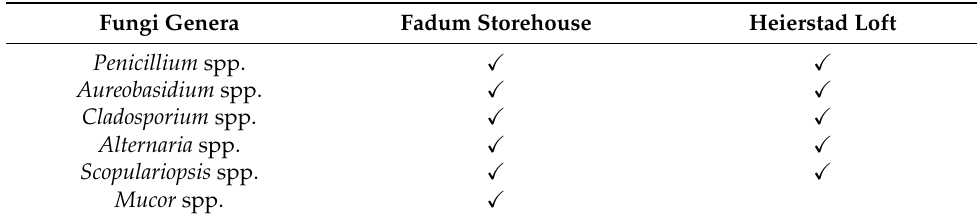
Figure 10. Fungal structures of ( a ) Penicillium spp. , ( b ) Aureobasidium spp. , ( c ) Cladosporium spp. , ( d ) Alternaria spp. , ( e ) Mucor spp. , and ( f ) Scopulariopsis spp. after methylene blue staining. Table 4. Fungi genera identified from the samples collected from the two case studies.